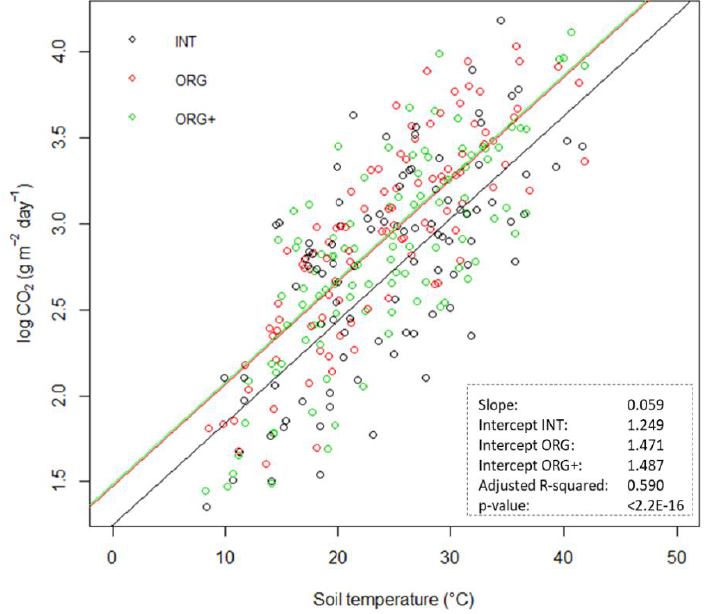
Figure 8. Relationship between the logarithm of CO 2 flux and the soil temperature.